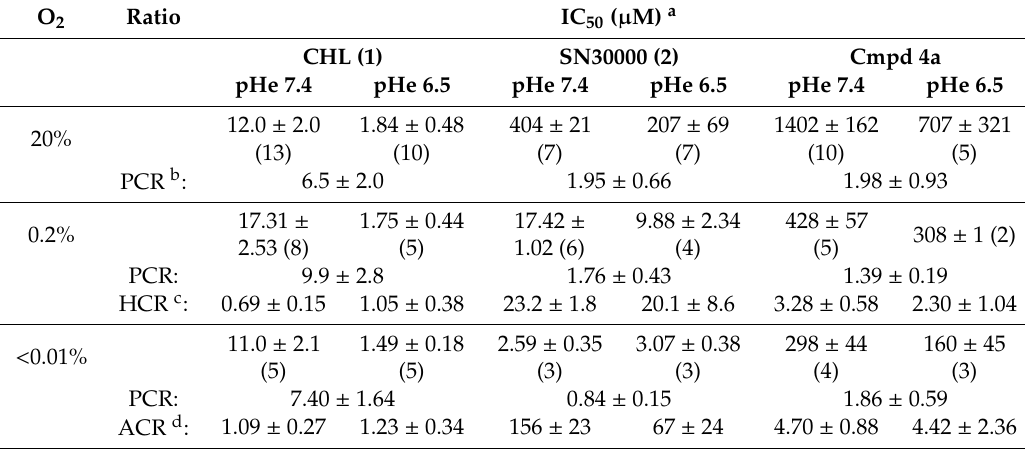
Footnotes: a Values are mean and errors are SEM, with the number of experiments in brackets. b pH cytotoxicity ratio (IC 50 for pHe 7.4 / IC 50 for pHe 6.5). c Hypoxic cytotoxicity ratio (IC 50 for 20% O 2 / IC 50 for 0.2% O 2 ). d Anoxic cytotoxicity ratio